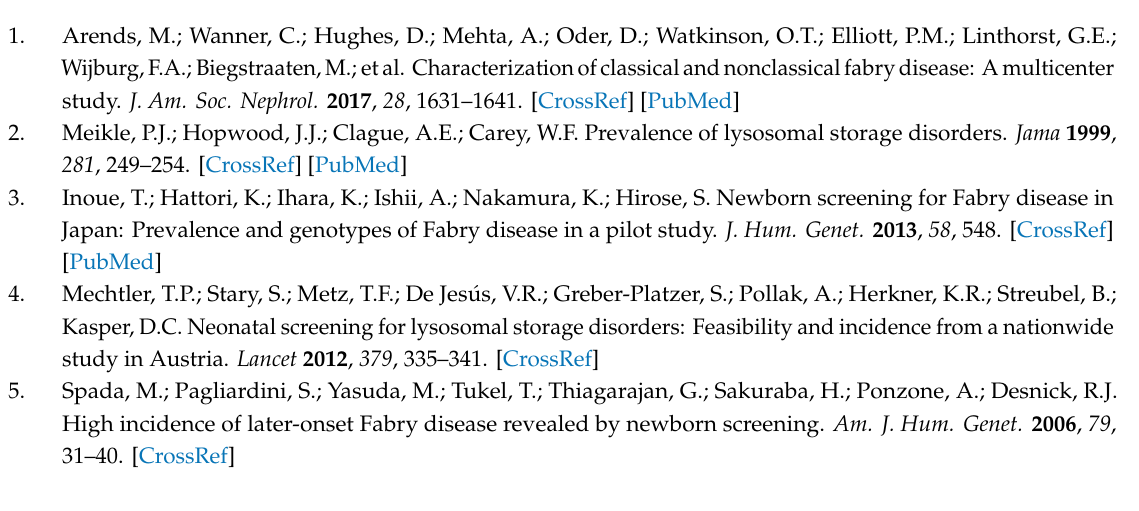
Figure S1: Scatter plots and correlation in treated Fabry samples with classical phenotype, Figure S2: Scatter plots and correlation in non-treated Fabry samples with classical phenotype, Figure S3: Scatter plots and correlation in treated Fabry samples with non-classical phenotype, Figure S4: Scatter plots and correlation in non-treated Fabry samples with non-classical phenotype, Table S1: Clinical and proteomic data, Table S2: Summary statistics of the clinical characteristic of the cohort, Table S3: Correlation results of the proteomic data, Table S4: Results of di ff erential analysis statistics, Table S5: Results of the ANOVA